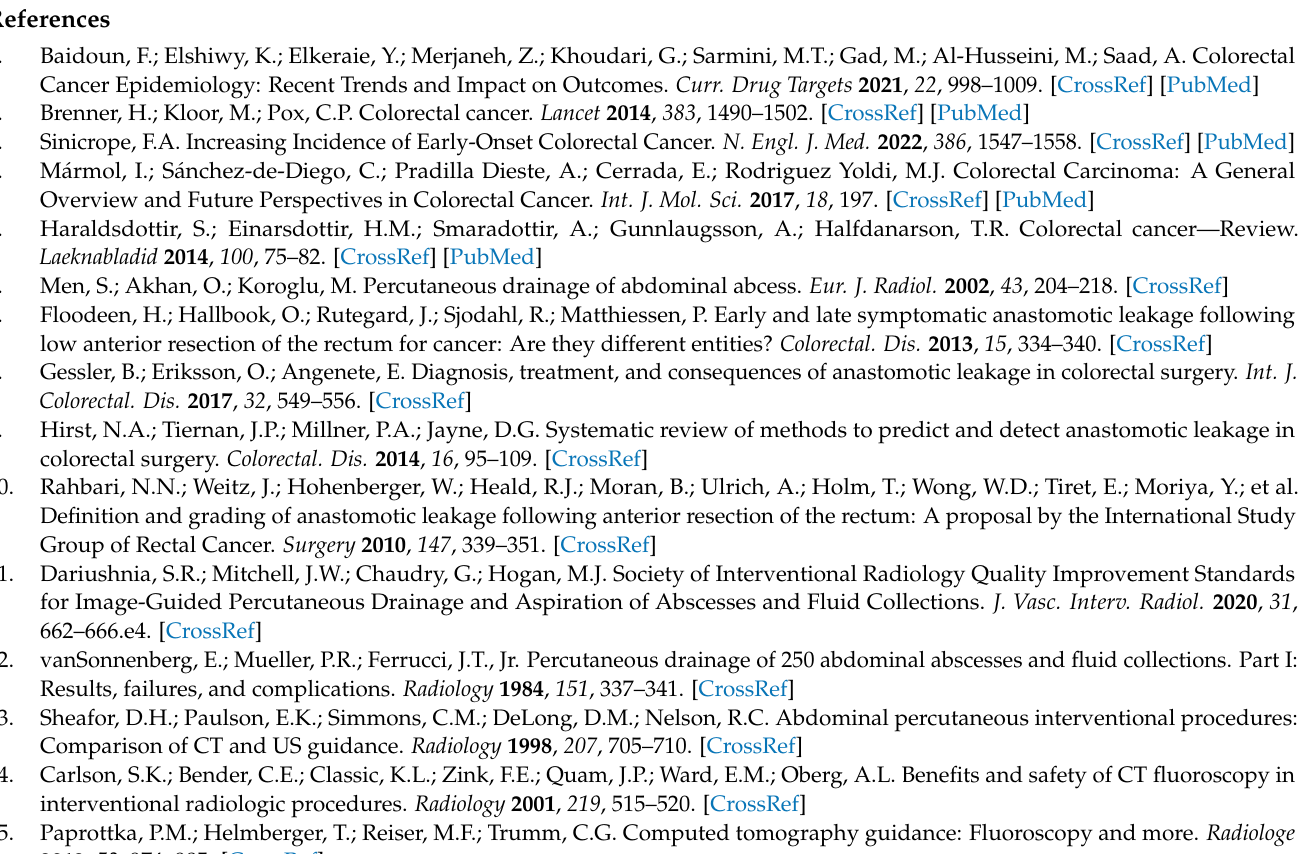
Table S3: Distribution of the success rate in terms of decreasing laboratory parameters among the different applied surgical procedures; Table S4: Visual appearance of the drainage fluid depending on the infection status and presence of anastomotic leakage; Figure S1: Determination of horizontal insertion angle and horizontal insertion height of the drain; Figure S2: Boxplots of the median radiation dose during the observation periods; Figure S3: Microbiological